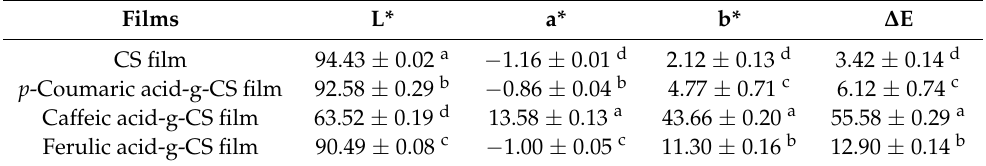
Figure 3. Physical appearances ( A ) and UV-vis light transmittance ( B ) of chitosan (CS) and different hydroxycinnamic acid-g-CS films. Table 1. Color parameters including L * , a * , b * and Δ E of chitosan (CS), p -coumaric acid-g-CS, caffeic acid-g-CS and ferulic acid-g-CS films.